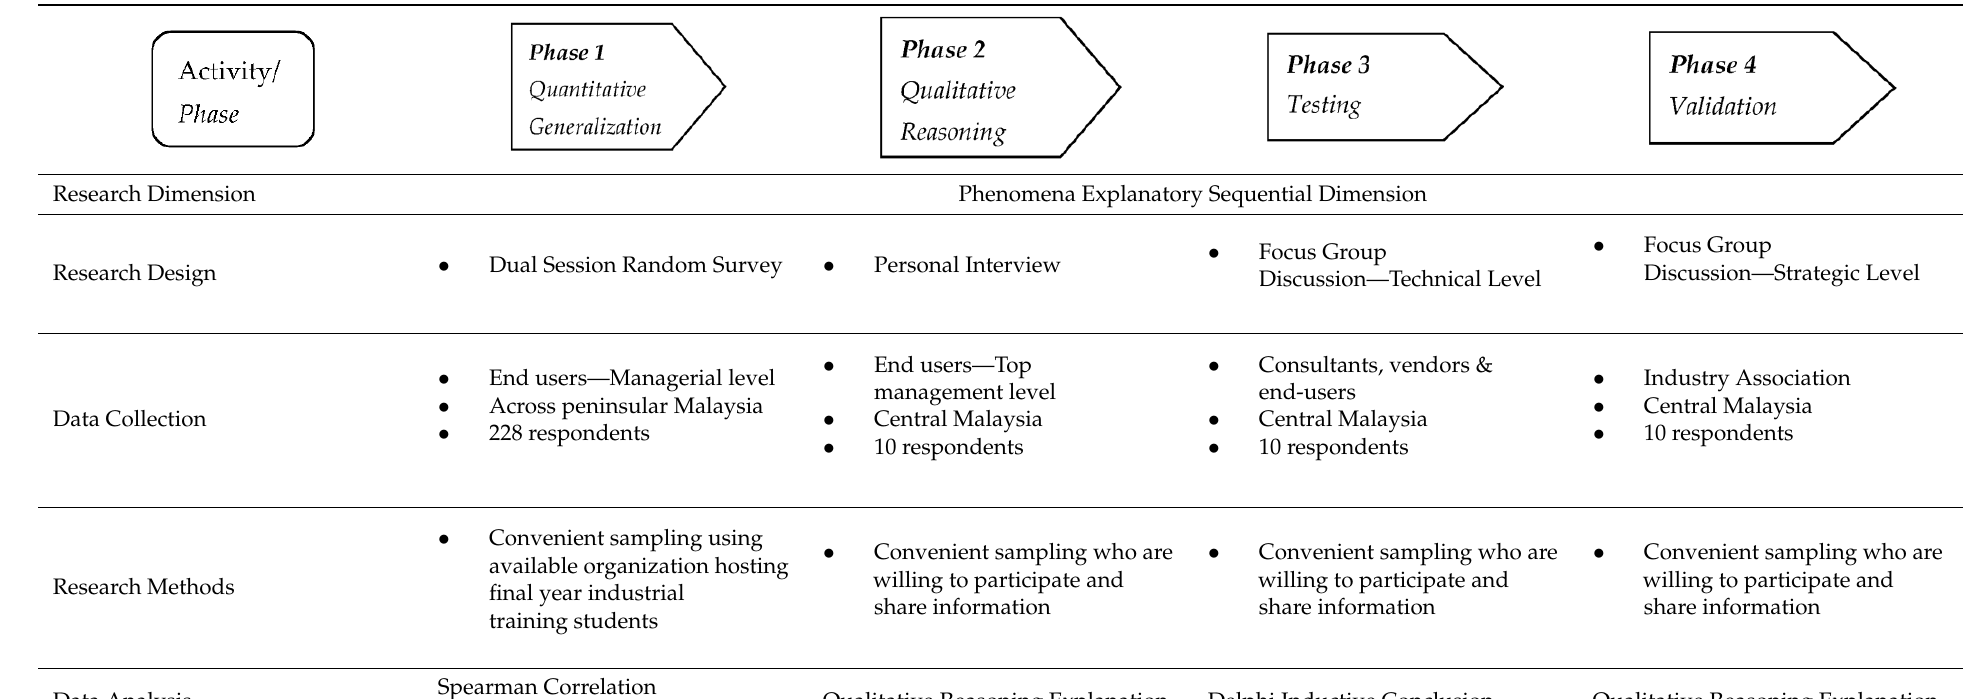
Table 1. Research Methodology Summary.